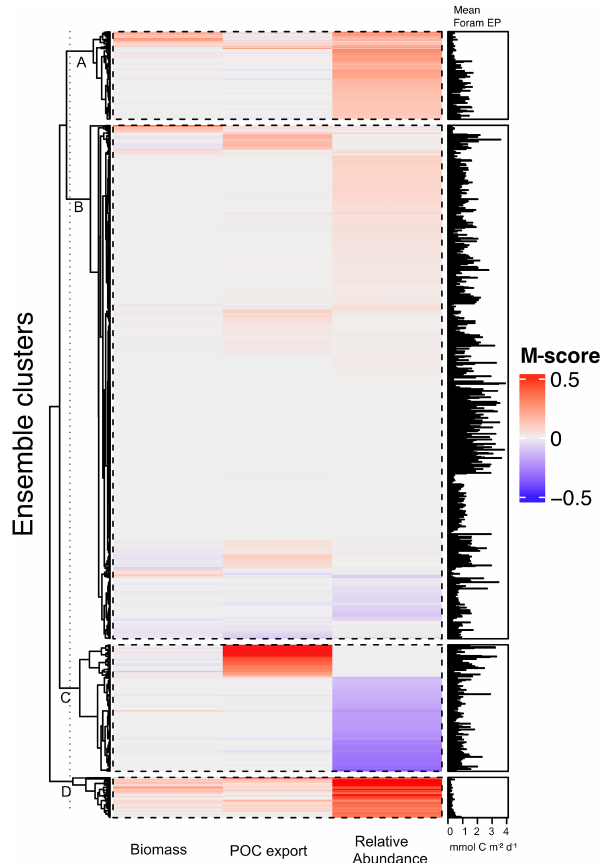
Figure 2. Foraminiferal M-score heatmap of the model ensemble for foraminiferal biomass (plankton net data), POC export (sedi- ment trap data), relative abundance (sediment core-top data). Each of the first three columns shows the M-score sum of the four foraminiferal groups, and the fourth column shows the sum of the left three columns. The right panel shows the global annual mean export production of all foraminiferal groups. The ensemble clus- ter was derived from a complete linkage clustering algorithm (Leg- endre and Legendre, 1998). Higher M-scores have a better perfor- mance against observations, whilst negative values stand for nega- tive